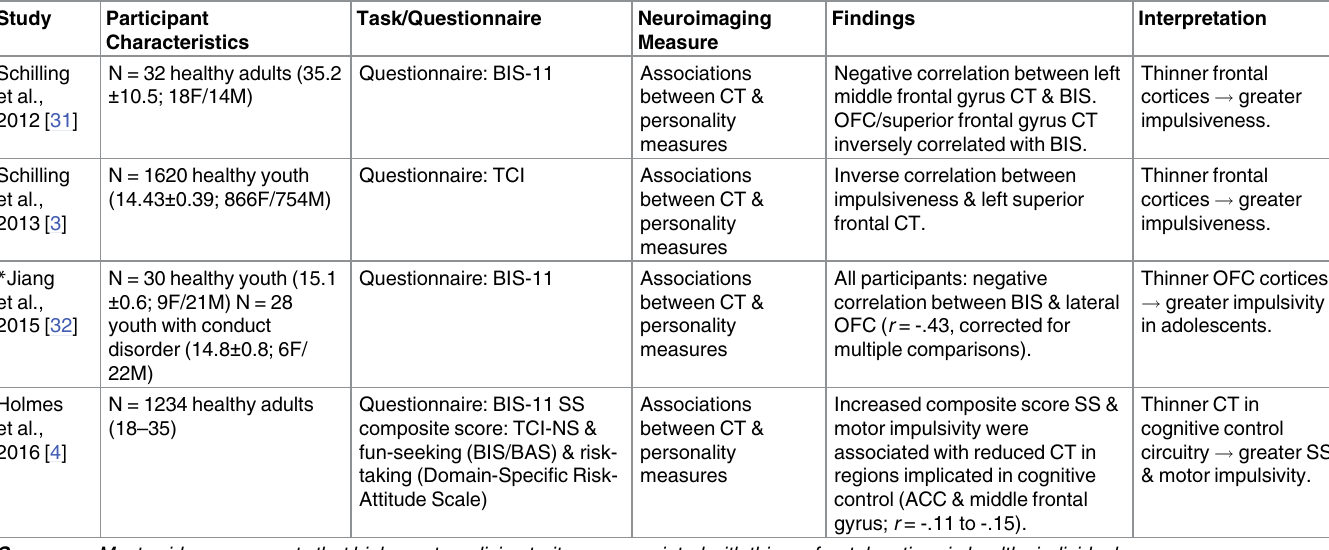
Table 3. Associations between frontal cortical thickness & externalizing personality